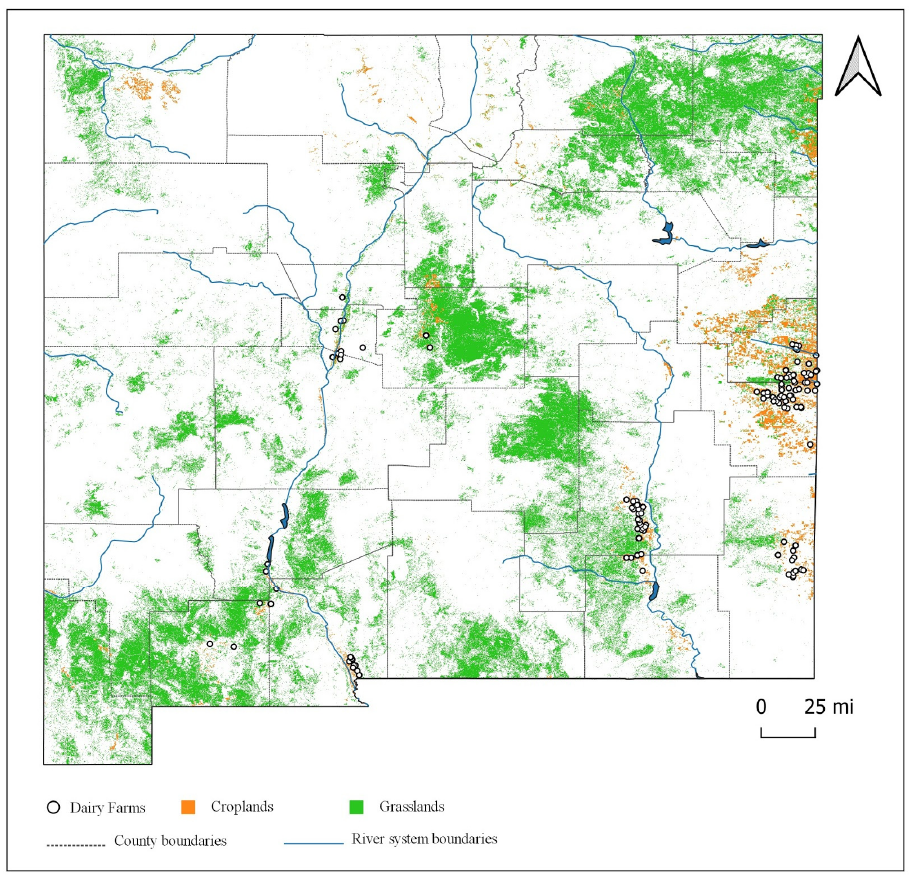
Figure 2. Croplands and grasslands in New Mexico, US.